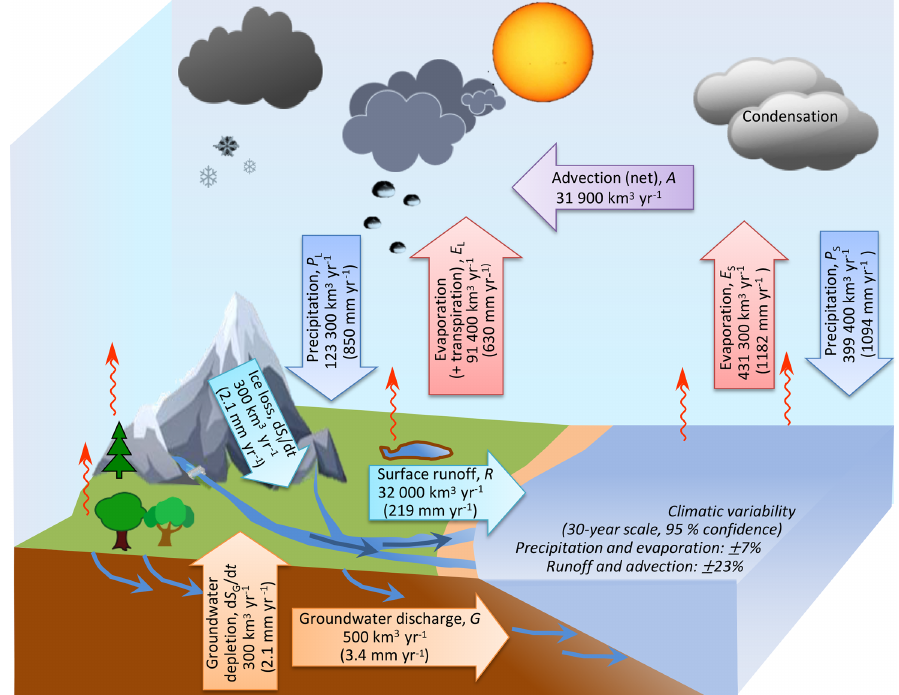
Figure 14. Proposed quantification of water